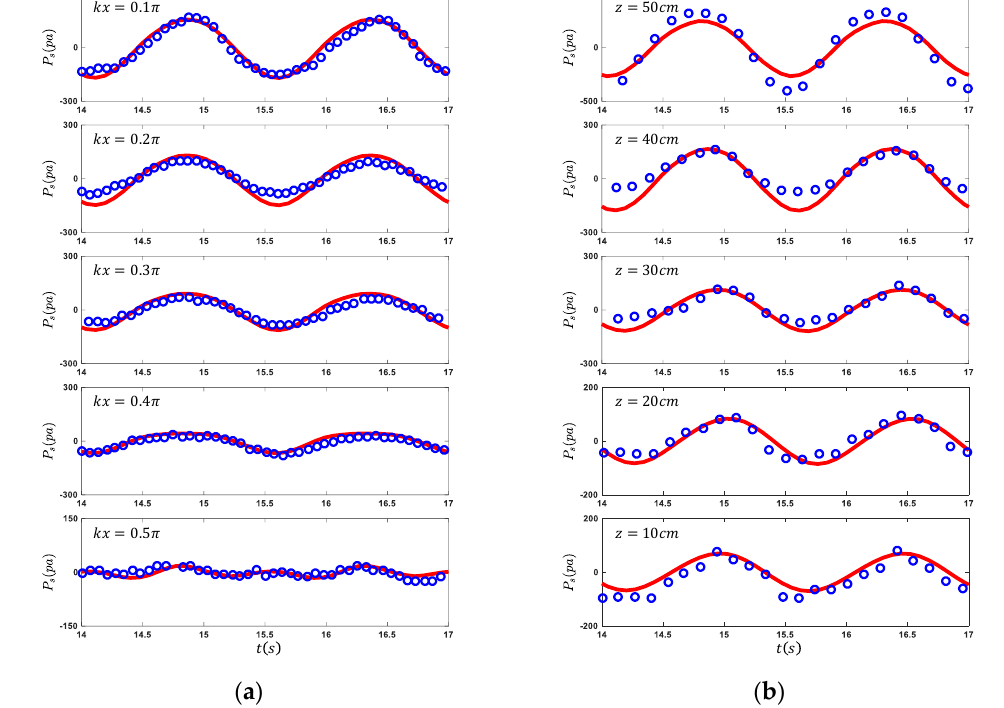
Figure 4. Time histories of the wave − induced oscillatory pore pressure at the various horizontal positions at 𝑧 = 40 cm . Symbols: red lines: numerical results, ○ : experimental data. ( a ) Pressure on the line, parallel with the seabed surface. ( b ) Pressure on the right side of the sand bed.